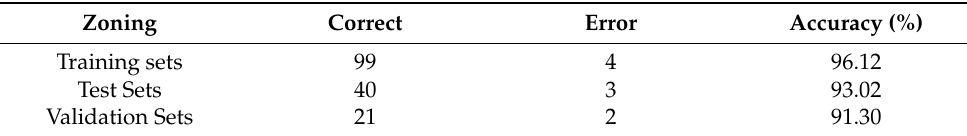
Table 6. Classification results of sinus tachycardia image recognition model.